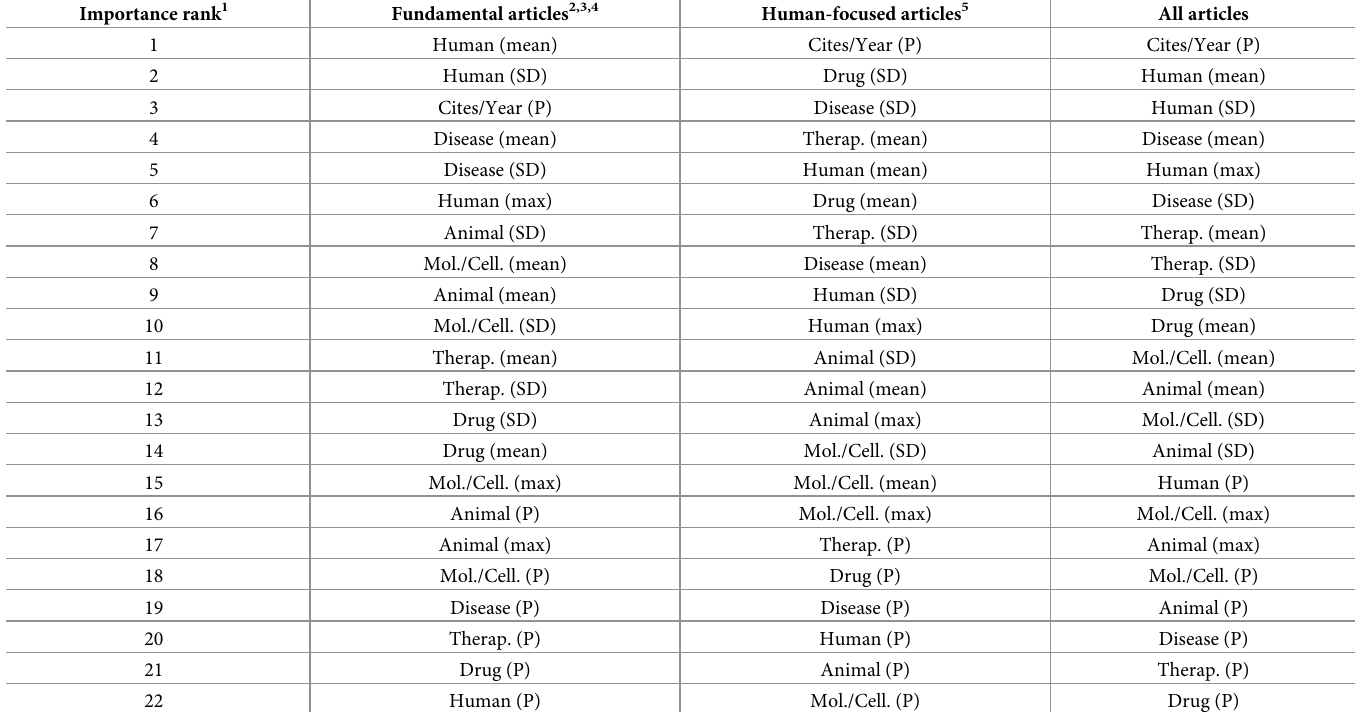
Table 2. Importance rank of features for